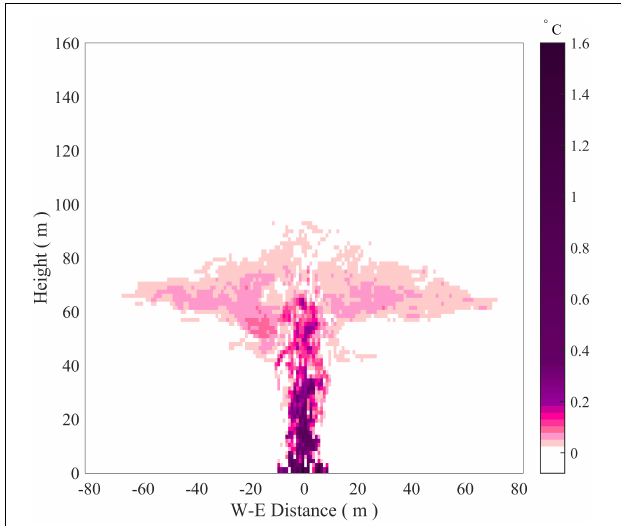
FIGURE 7 | Temperature anomalies for a simulated plume rising from a flat bottom into a stratified environment with zero ambient flow. The source heat flux for the plume is 10 MW and the area over which that source is distributed is 20 × 20 m. Background hydrography for the model is derived from CTD data taken from WOCE Station P16-220. The maximum height reached by the simulated plume is ∼ 90 m above the seafloor and the lateral dispersion height for the non-buoyant plume is centered at ∼ 65 m above bottom (equivalent to 1395–1400 m depth for a plume source situated on the shallowest 5 m of the TH1 cone at Teahitia (1460–1465